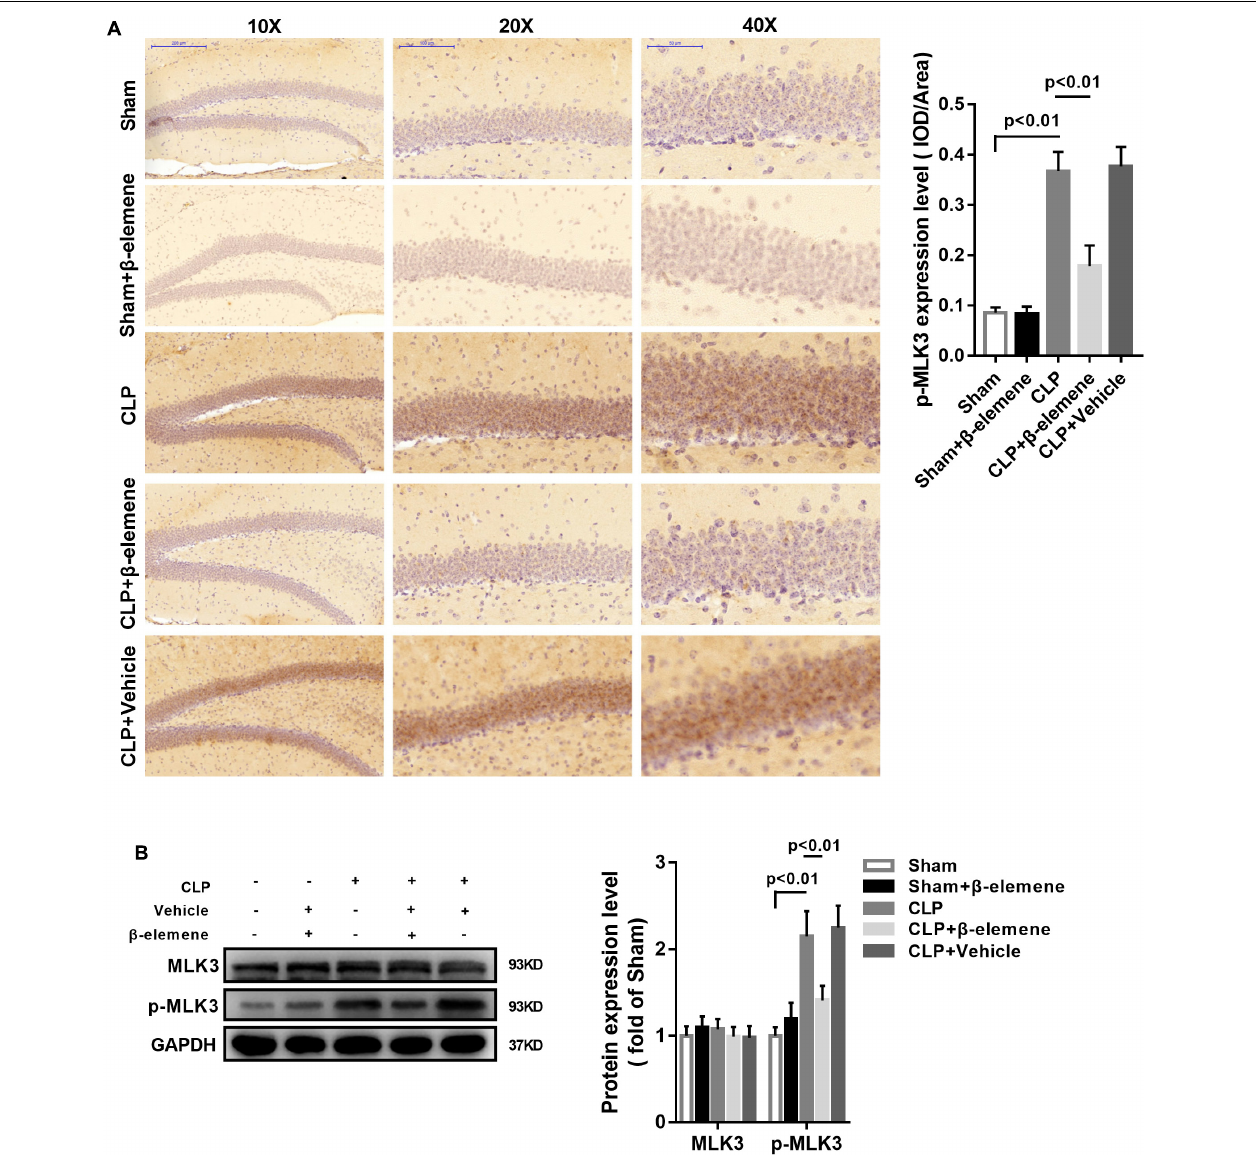
FIGURE 7 | β -Elemene reduced MLK3 phosphorylation in the hippocampus of CLP mice. (A) Immunohistochemical staining exhibited that β -elemene significantly attenuated MLK3 phosphorylation. F(4, 15) = 64.04. (B) Western blotting presented that β -elemene significantly reduced MLK3 phosphorylation [F(4, 15) = 24.27] normalized to that of GAPDH. n = 4. One-way ANOVA revealed a significant difference at p <